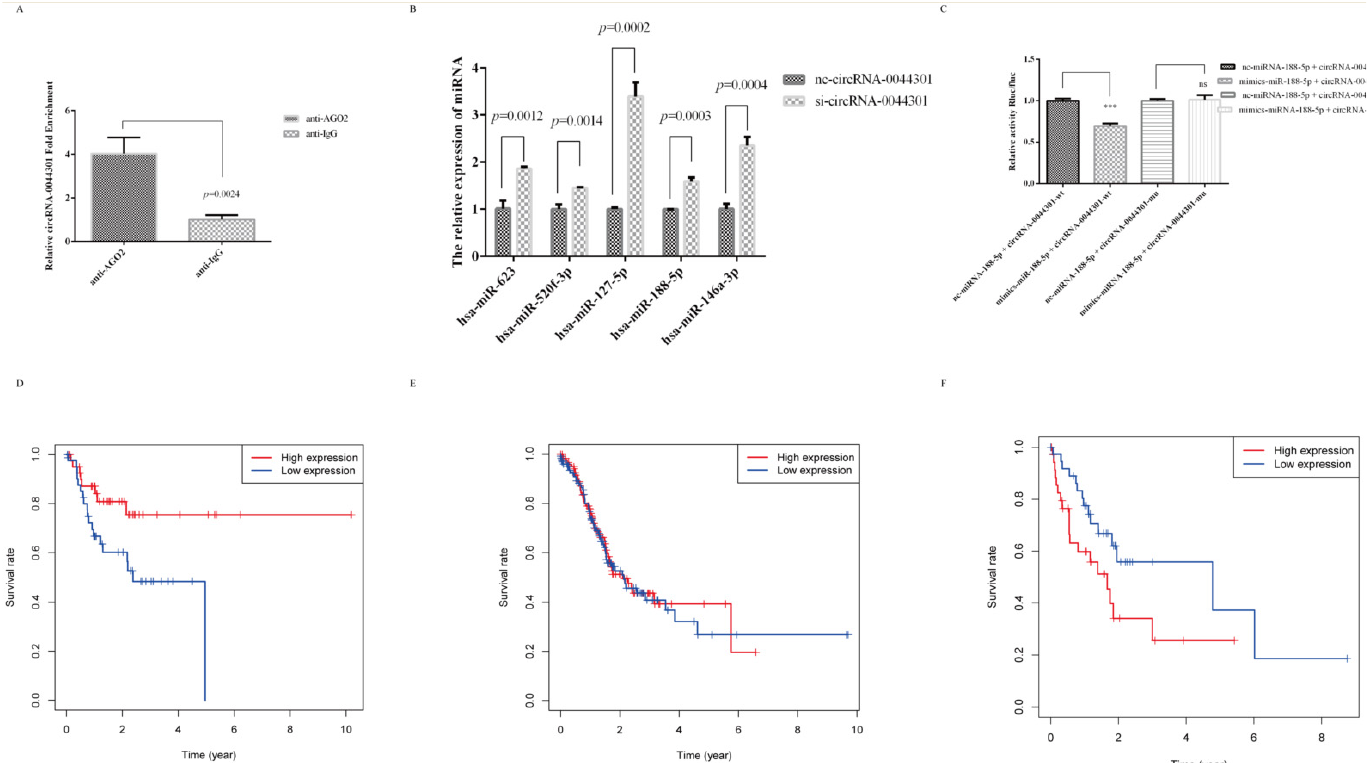
Figure 6. MiRNA-188-5p was sponged by circRNA-0044301 and was associated with GC patients’ prognosis. ( A ) AGO2-RIP assay results of circRNA-0044301 in HGC-27. ( B ) qRT-PCR of the expression of miRNAs in si-circRNA-0044301 and nc-circRNA-0044301 groups. ( C ) Luciferase reporter assay experiment in 293T cells co-transfected with circRNA-0044301 (mu or wt) and miRNA-188-5p (mimics or nc); the luciferase activity of the 293T cells transfected with circRNA-0044301 wt (wt-circRNA-0044301) sequence was significantly reduced but no significant inhibitory effect was observed in those transfected with the circRNA-0044301 mu sequence (mu-circRNA-0044301), (***: p < 0.001; ns: no difference). ( D ) Survival curve of GC patients less than or equal to 56 years in the high- and low miRNA-188 expression groups showed that a low miRNA-188 expression level was significantly associated with a poor prognosis ( p = 0.017). ( E ) Survival curve of GC patients more than 56 and less than or equal to 75 years in the high and low miRNA-188 expression groups showed no difference ( p = 0.859). ( F ) Survival curve of GC patients more than 75 years old in the high and low miRNA-188 expression groups showed that a high miRNA-188 expression level was significantly associated with a poor prognosis of GC patients ( p = 0.048).